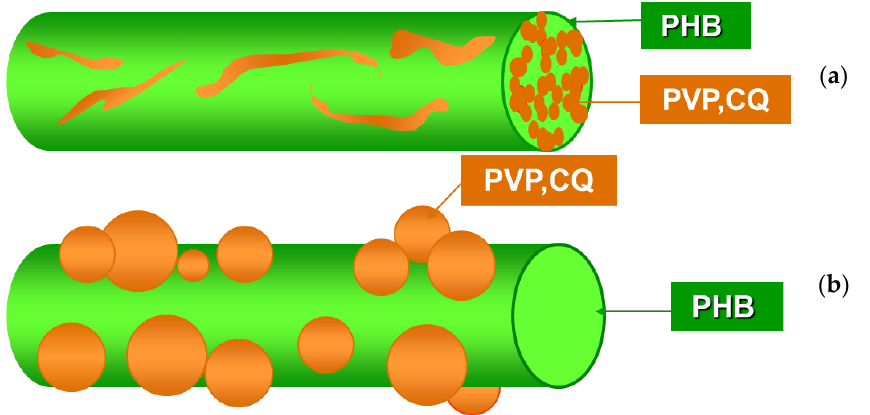
Figure 1. Schematic representation of fibers: ( a ) PVP in PHB fiber loaded with CQ in the bulk (PVP,CQ in PHB) and ( b ) PHB fiber decorated with PVP,CQ particles on the surface (PVP,CQ on PHB).